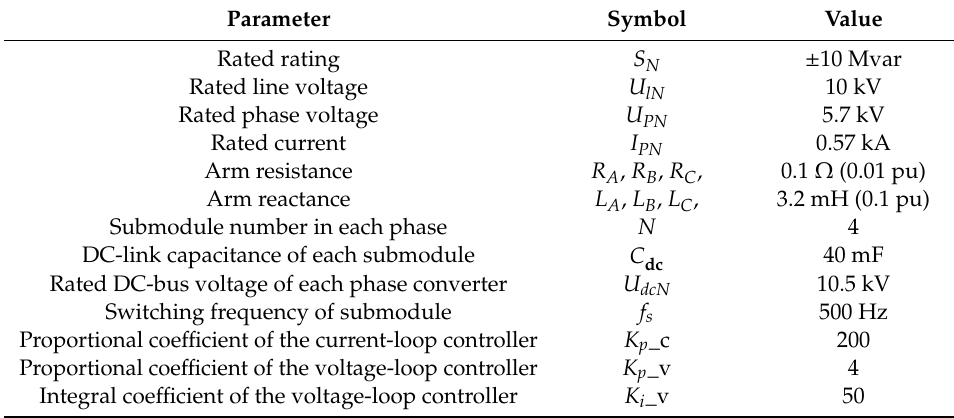
Table 1. Parameters in the simulation